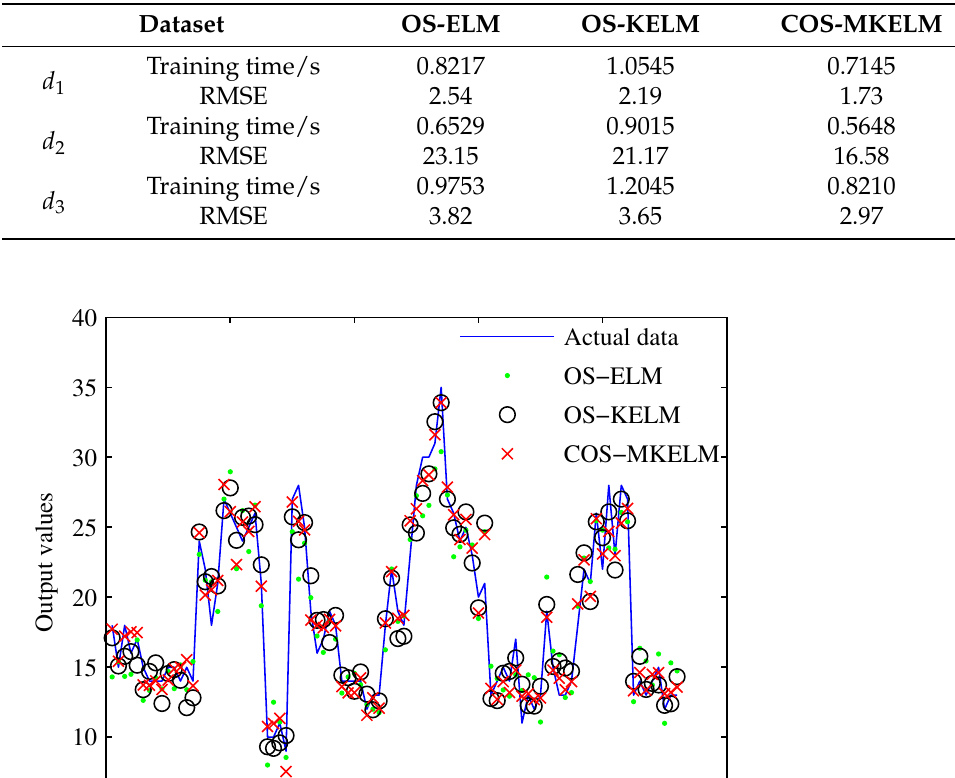
Table 1. Performance comparison of the three learning algorithms on UCI regression datasets.